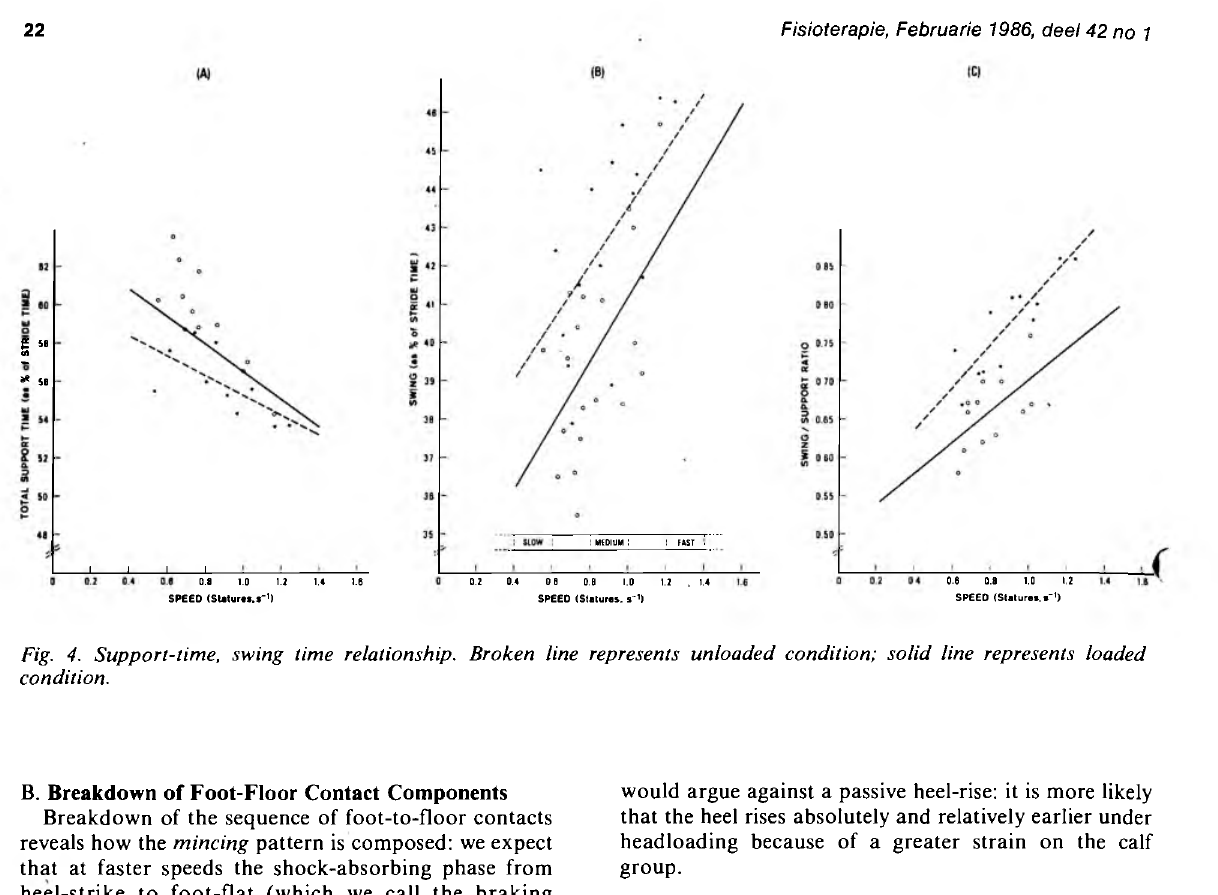
B. Breakdown of Foot-Floor Contact Components Breakdown of the sequence of foot-to-floor